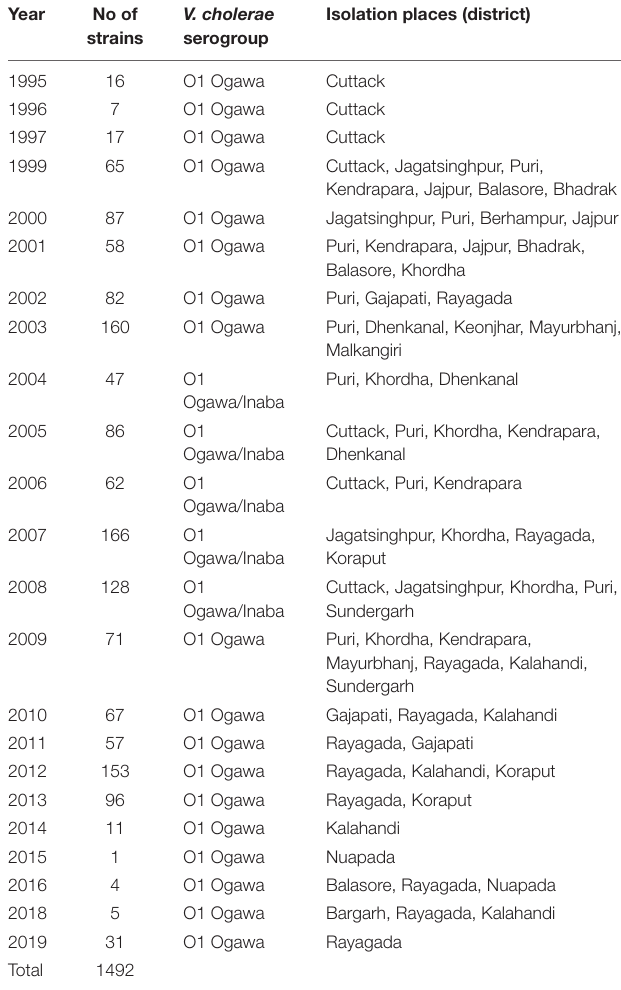
TABLE 1 | Year-wise isolation of Vibrio cholerae O1 strains from different districts of Odisha: